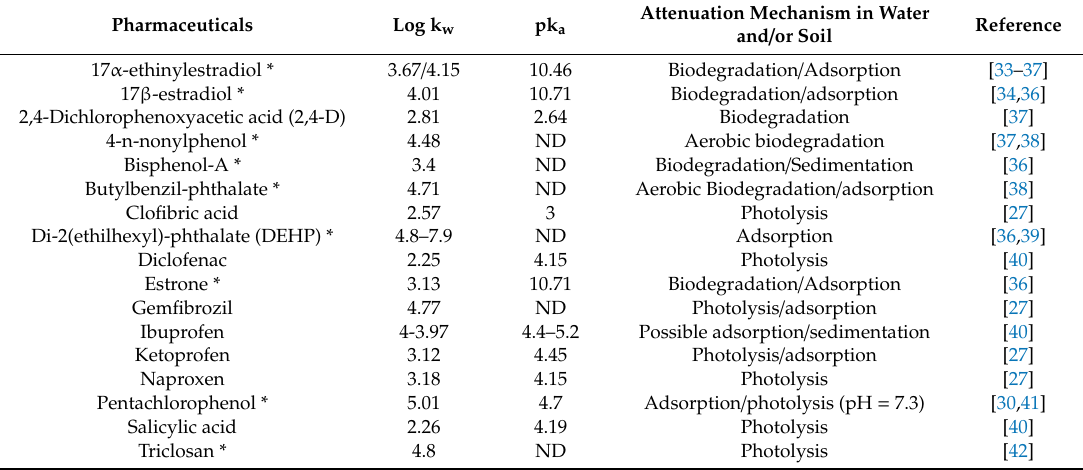
Table 5. Main attenuation mechanisms of analyzed